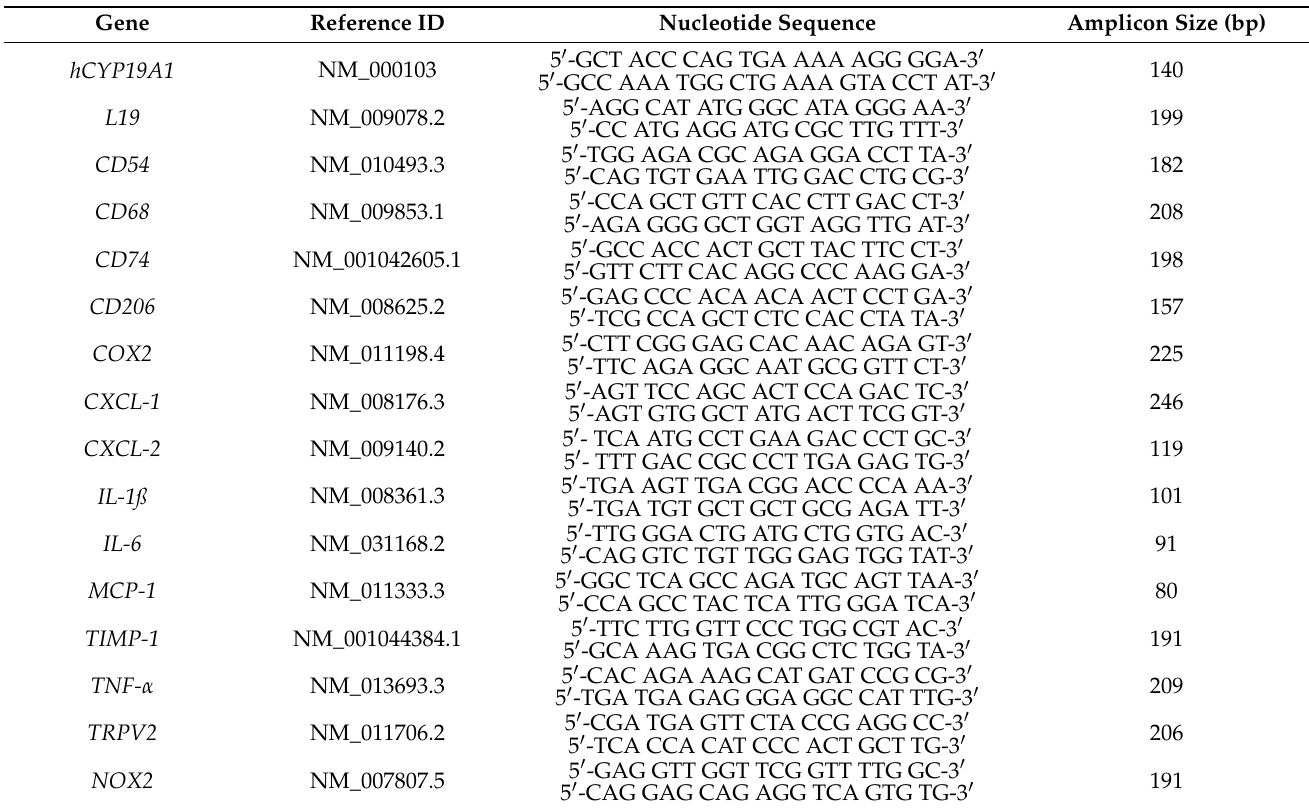
Table 1. Oligonucleotide primer sequences and corresponding amplicon